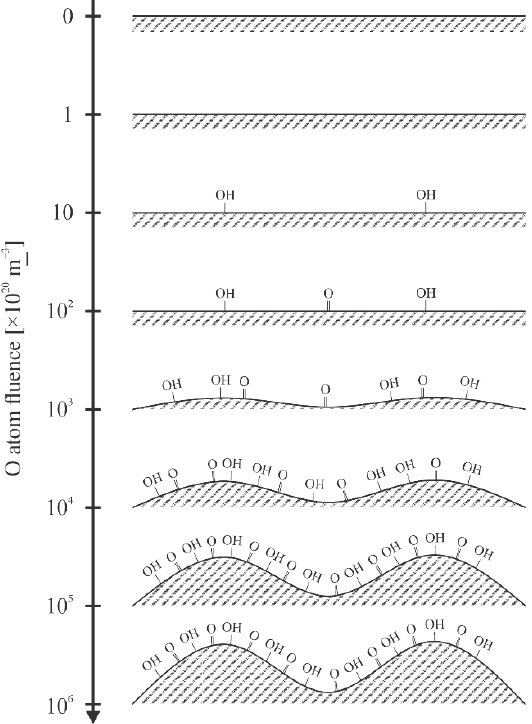
Figure 5. Illustration of the interaction of O-atoms with polyethylene terephthalate (not to scale). The aspect ratio between the height and the lateral dimension of the hills at the fluence of 10 25 m − 2 is about 0.04.